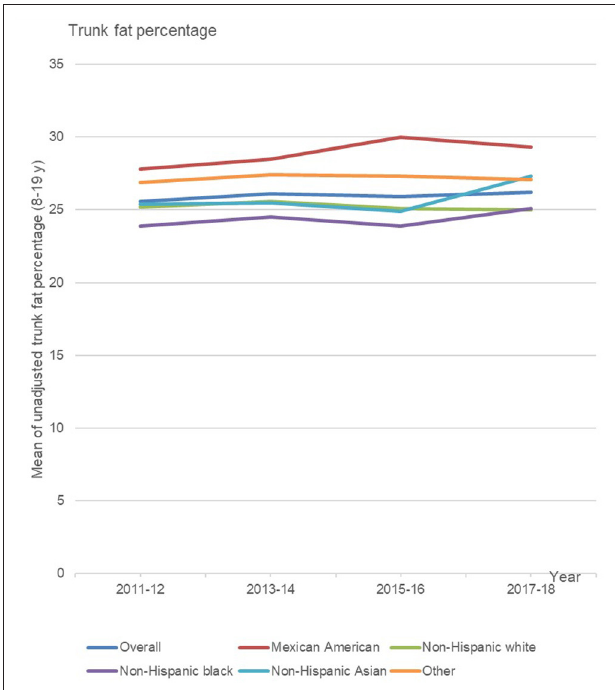
FIGURE 2 | Trends in mean trunk fat percentage by race or ethnicity among US children aged 8–19 y, NHANES 2011–2012 to 2017–2018.